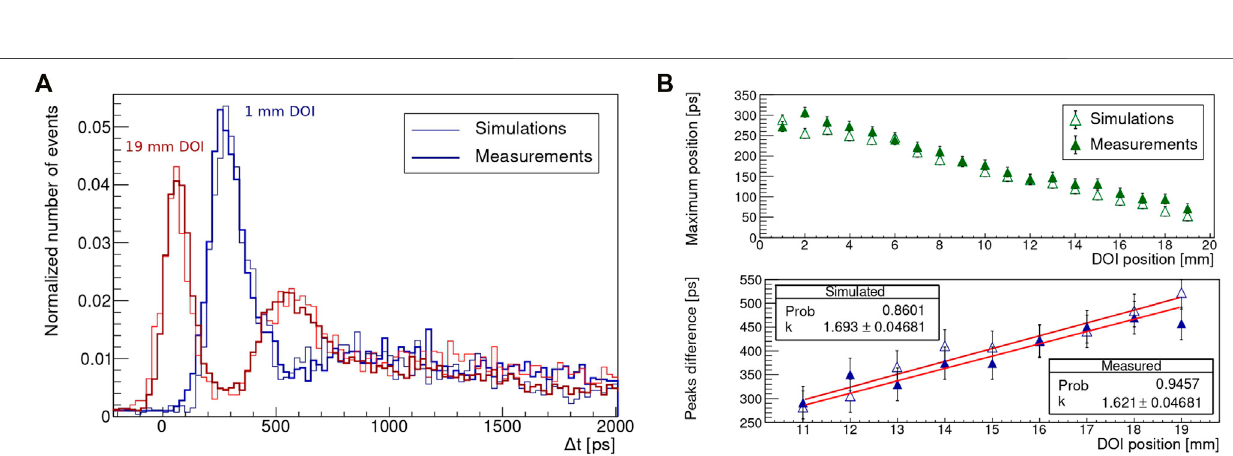
FIGURE5 |(A) Normalized time delay distributions for lateral DOI-collimated measurements.The measurementsare performed byplacingthe 3× 20 mm 2 face of the 20 mm long Te fl on-wrapped TlBr crystal in coincidence with the reference detector. The source and the reference detector are moved in steps of 1 mm along the 20 mm side. (B) Corresponding DOI-collimated simulations.